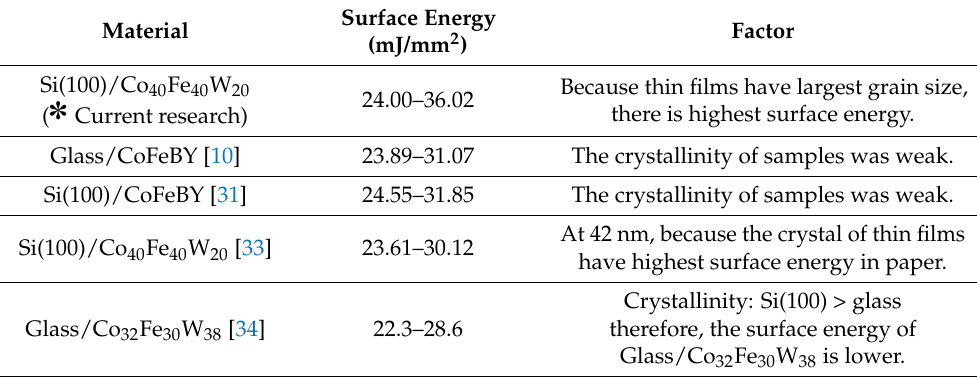
Table 2. Comparing surface energy for specific CoFeW and CoFeBY thin films from different substrates.